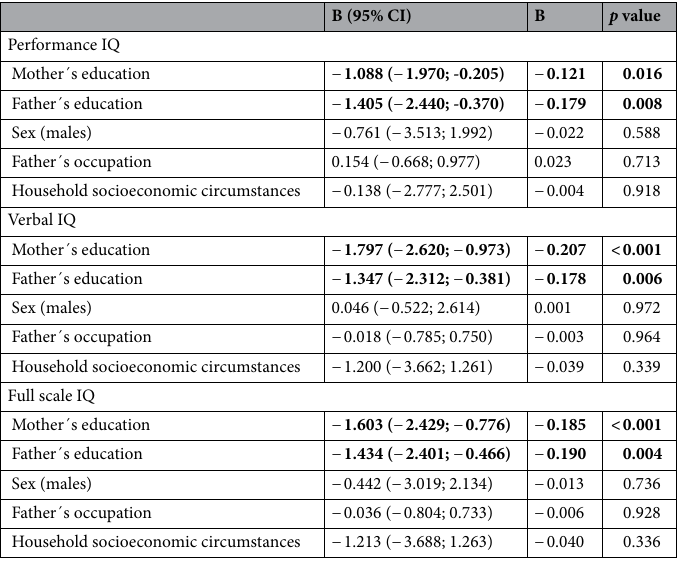
Table 1. Associations of parental education with cognitive ability at age 8. IQ = intelligence quotient; B = unstandardized coefficient from linear regression; β = standardized coefficient from linear regression; CI = confidence interval. All variables are included in the models. Significant values are in